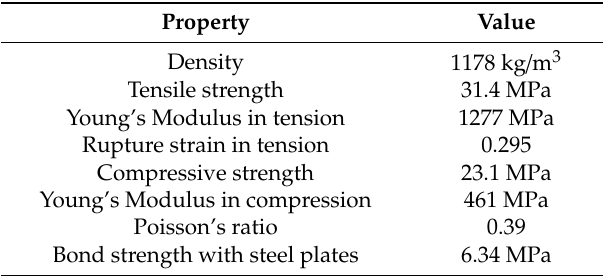
Table 1. Mechanical properties of the nano-composite used in this study.